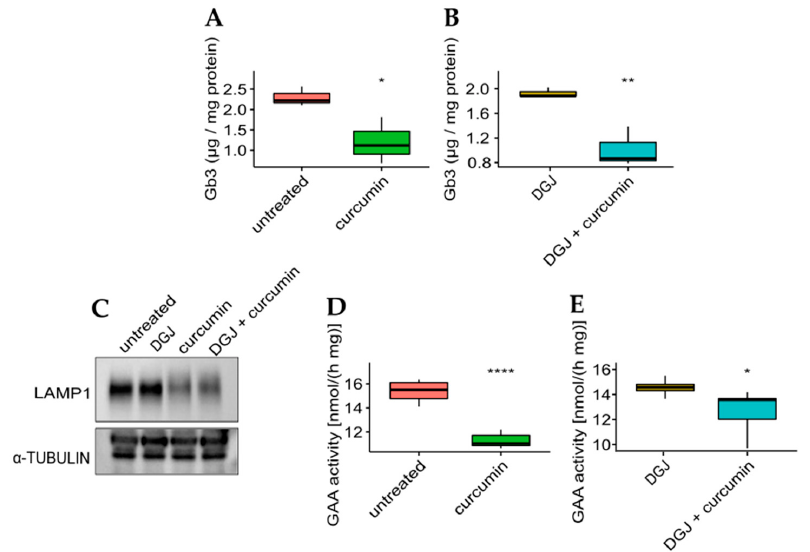
Figure 7. Curcumin treatment improved Gb3 clearance and lysosomal markers. ( A , B ) IF-GLA-L300F cells were treated for 50 days with drug administration once a week. At the end of the treatment (day 50), cells were collected and lipids were extracted through a methanol:chloroform:water protocol. Lipid content was measured via LC-MS/MS. ( A ) IF-GLA-L300F treated with 20 µ M curcumin or with no drug showed improved Gb3 clearance upon curcumin treatment (two-tailed unpaired t -test, * = p < 5 × 10 − 2 , n = 3, p . 3.79 × 10 − 2 ). ( B ) IF-GLA-L300F treated with 10 µ M DGJ and 20 µ M curcumin showed Gb3 clearance improved with respect to DGJ monotherapy (two-tailed unpaired t -test; ** = p < 1 × 10 − 2 , n = 3, p . 8.96 × 10 − 3 ). ( C – E ) IF-GLA-L300F cells were treated for 15 days with 10 µ M DGJ, 20 µ M curcumin, or with both drugs. At the end of the treatment, the immunoblot showed a reduction in the levels of lysosome-associated membrane glycoprotein 1 (LAMP-1) upon curcumin treatment with or without DGJ ( C ). In addition, a reduction in GAA activity was determined via an enzyme activity assay both in monotherapy ( D ) (two-tailed unpaired t -test, **** = p < 1 × 10 − 4 , n = 6, p . 3.95 × 10 − 6 ) or in combined therapy with DGJ ( E ) (two-tailed unpaired t -test * = p < 5 × 10 − 2 , n = 6, p . 3.3 × 10 − 2